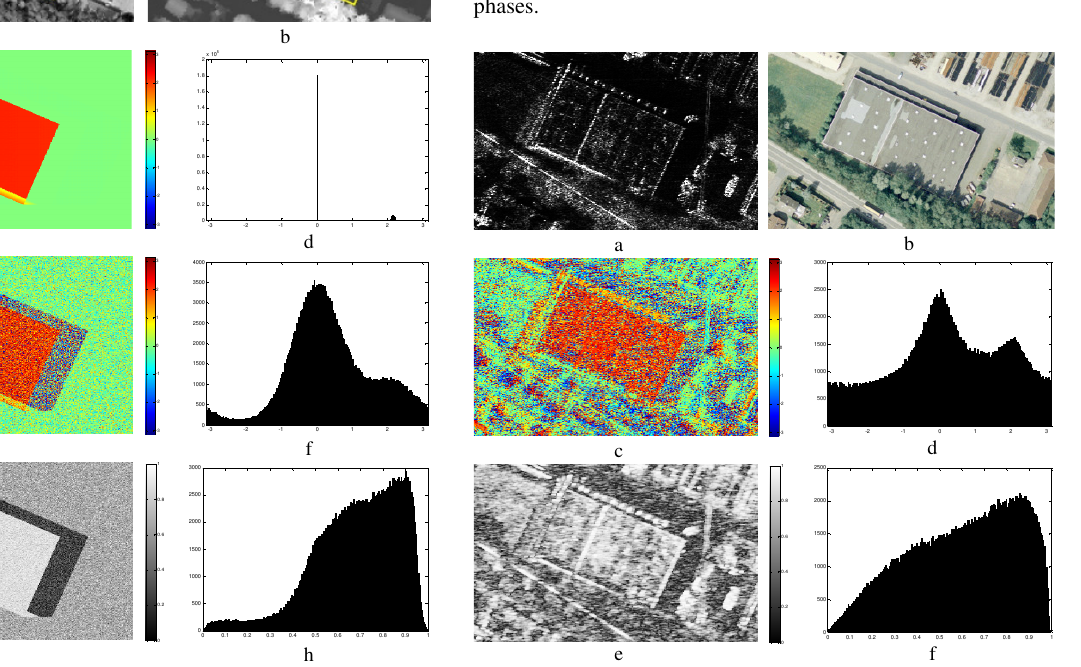
Figure 3. Real building signature: a) SAR magnitude , b) optical image, c) real phases and d) histogram, e) real coherence and f)